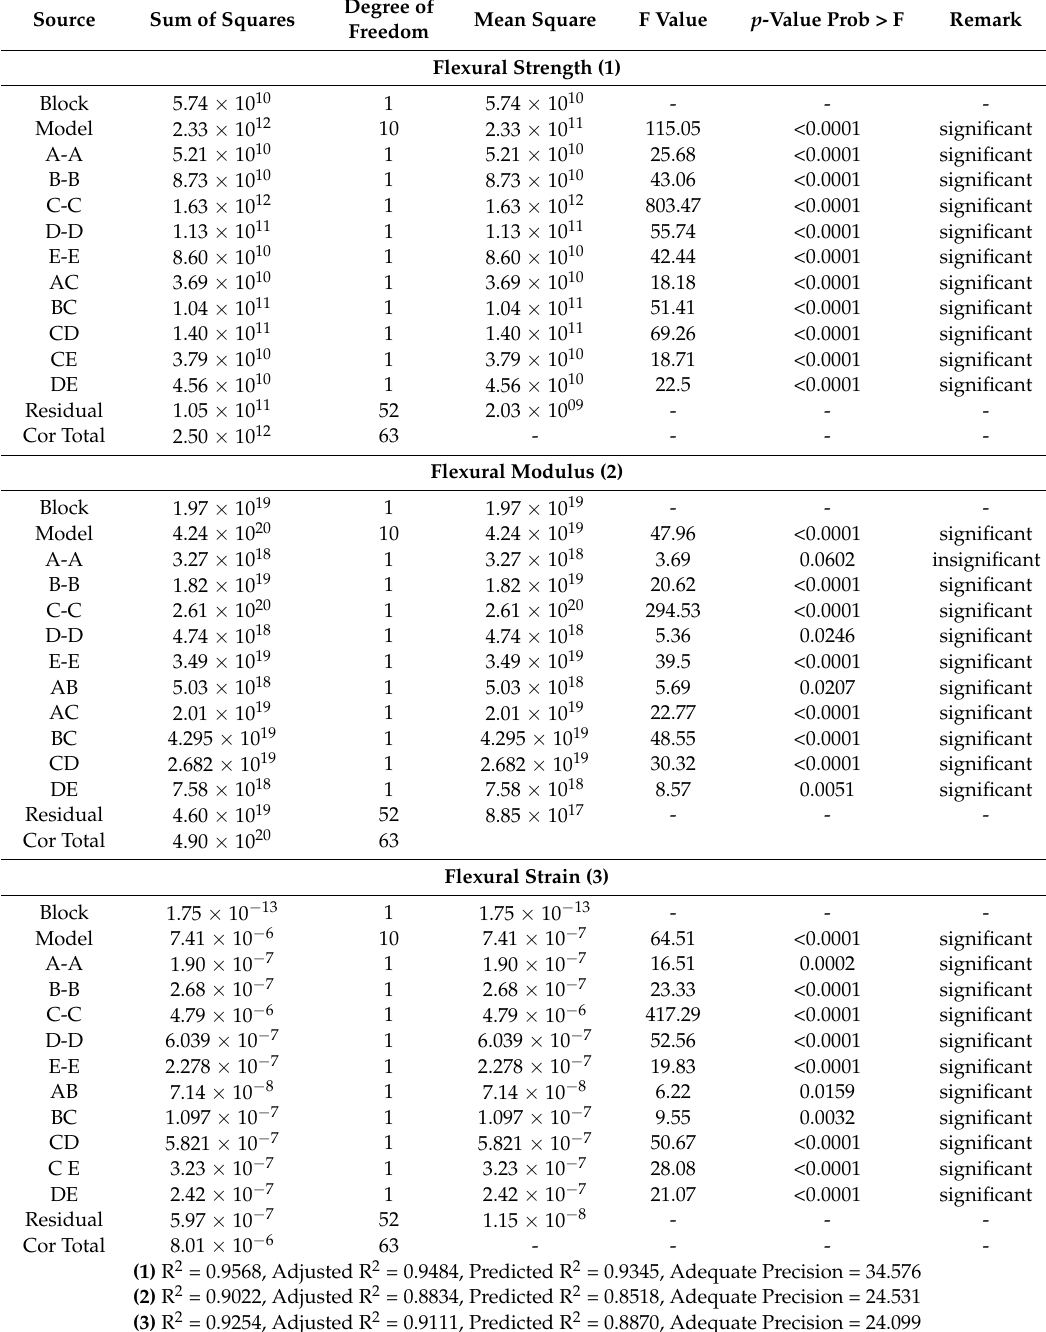
Table 3. Analysis of variance (ANOVA) table for the regression model developed for the